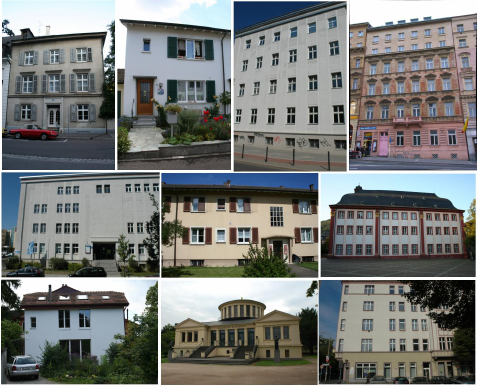
Figure 1: Example images from benchmark data set (Korˇc and F¨orstner,